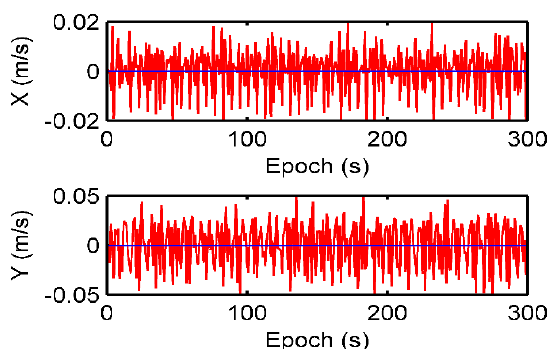
Figure 5. Positioning results using the Doppler differential positioning algorithm in the static test.